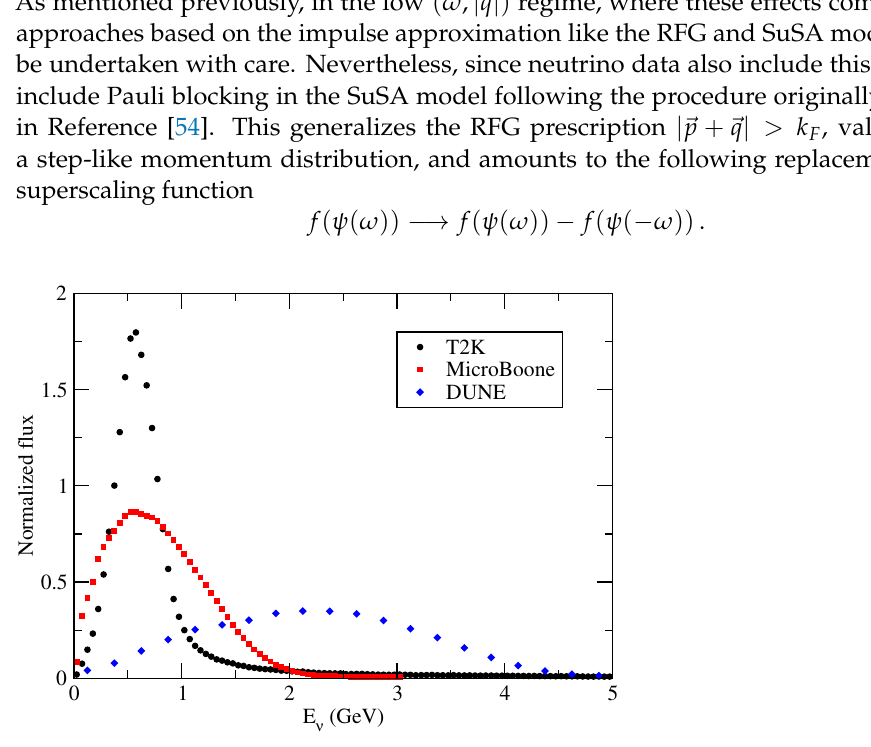
Figure 3. The normalized T2K (off-axis) [55], MicroBooNE [56] and DUNE [57] muon-neutrino fluxes displayed versus the neutrino energy E ν